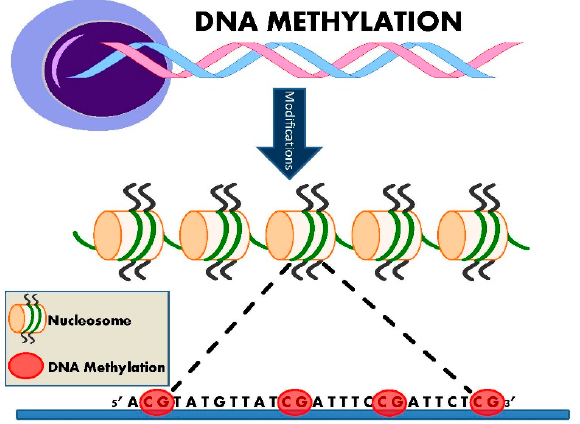
Figure 2. Epigenetic DNA methylation. DNA methylation involves the binding of a methyl group to